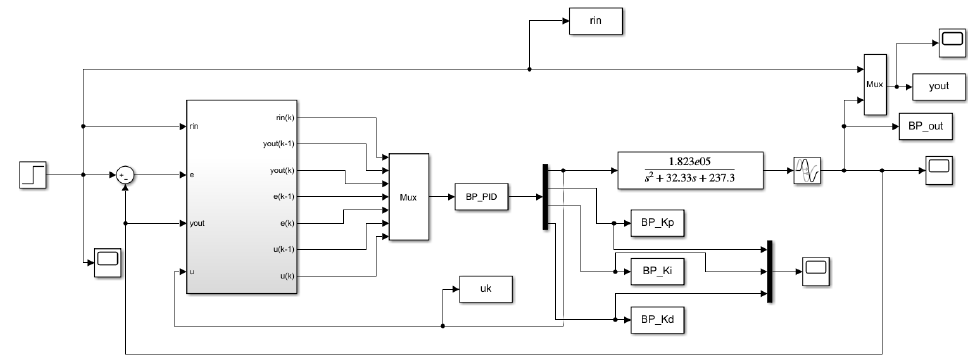
Figure 8. Simulation flow chart of the PSO-BP-PID controller.